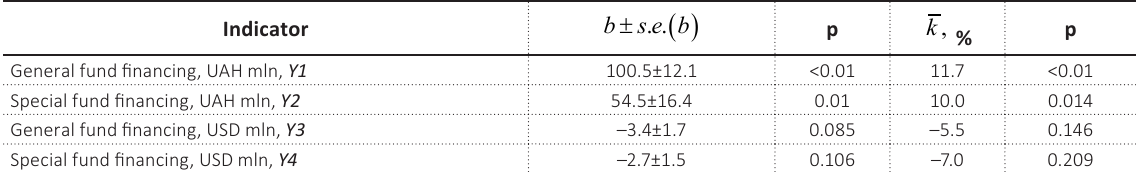
Table 2. Absolute and relative indicators for funding of the University, 2011–2020